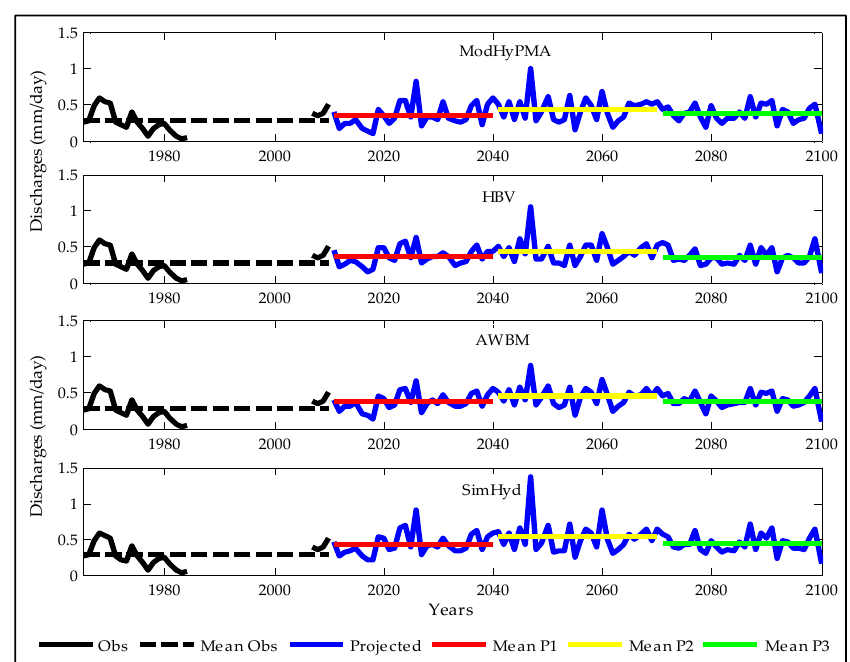
Figure 9. Evolution annual mean of projected discharge according to the RCP8.5 scenario.